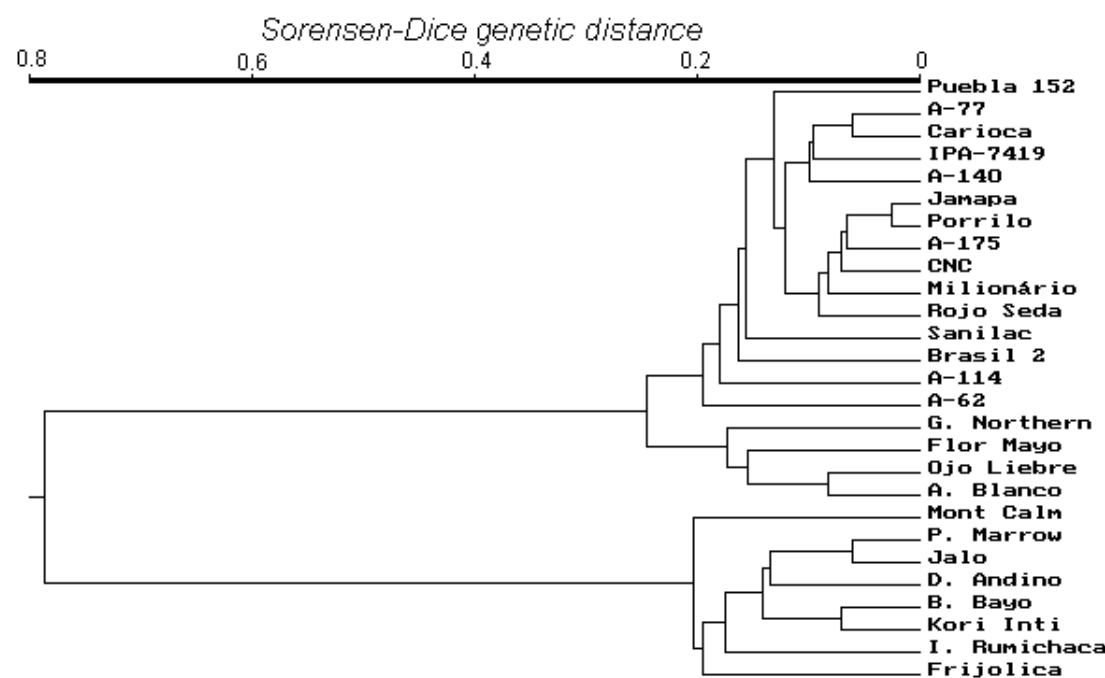
Figure 1 - Dendrogram of common bean cultivars based on RAPD data using UPGMA.